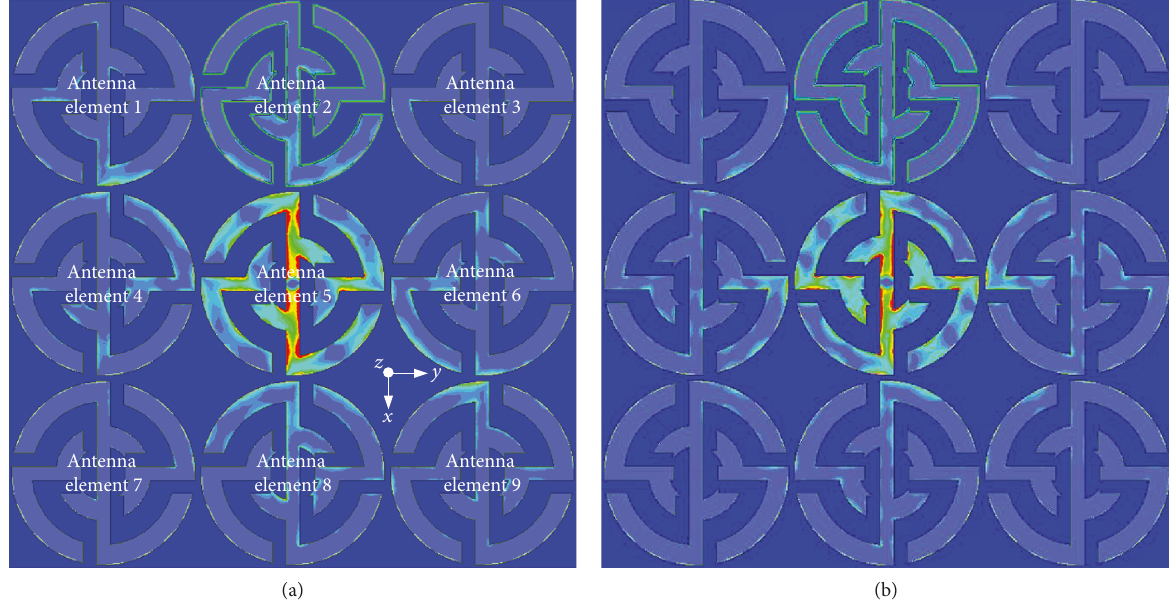
Figure 5: Surface current distribution on the MIMO antenna at (a) 26 GHz and (b)